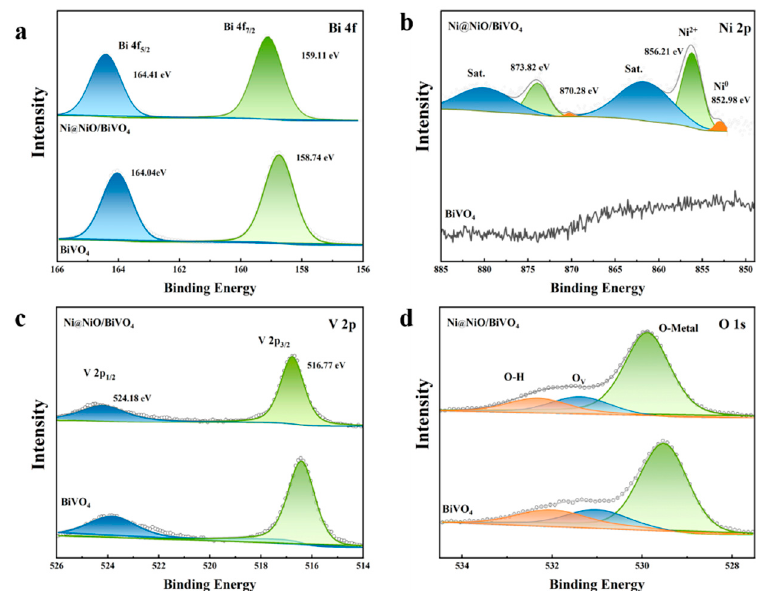
Figure 2. XPS of BiVO 4 and Ni@NiO/BiVO 4 photoanodes. ( a ) Bi 4f; ( b ) Ni 2p; ( c ) V 2p; and ( d ) O 1s.